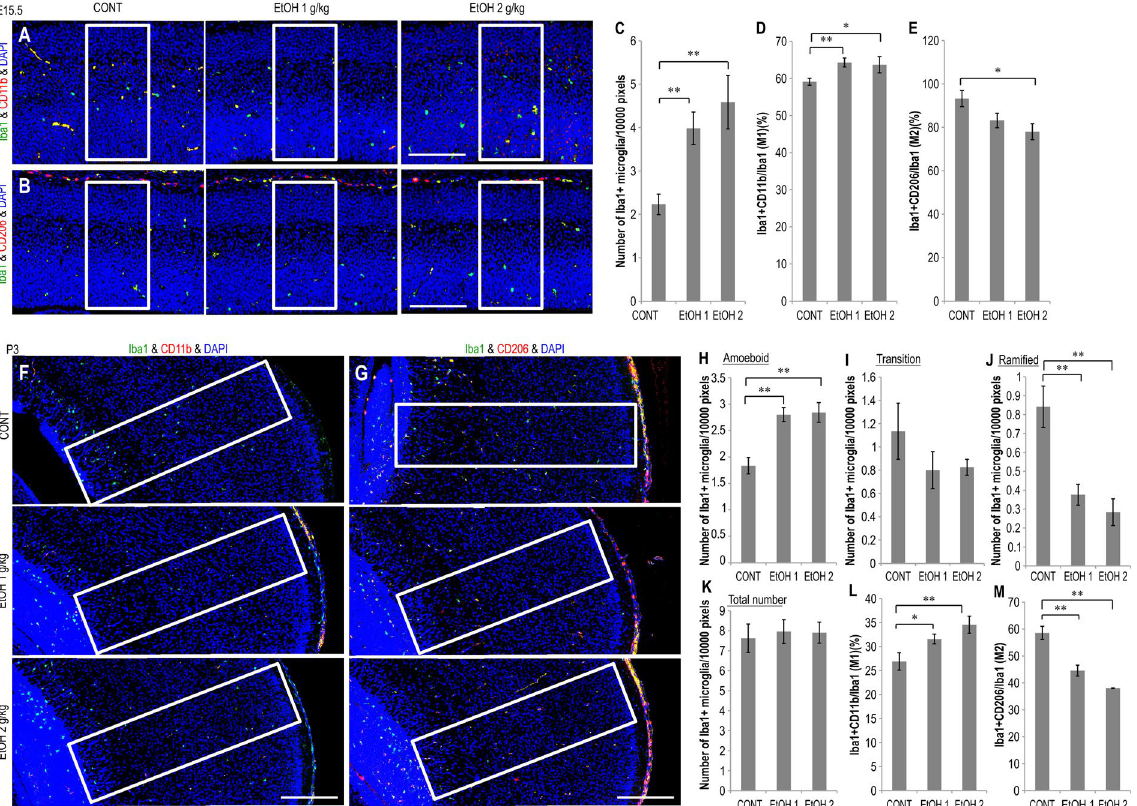
Figure 3. Effects of prenatal EtOH exposure on microglial number, morphology, and M1/M2 ratio in embryos and newborns. Prenatal exposure to EtOH altered microglial number and morphology and increased the ratio of M1/M2 activation in embryos and newborns. ( A , B ) Images of parasagittal sections at E15.5 obtained via double-immunostaining with anti-Iba1 and anti-CD11b (M1 microglial marker) or anti-CD206 (M2 microglial marker) antibodies (n = 6, respectively). ( C ) Graph depicting the index of Iba1 + microglia at E15.5. ( D ) Graph depicting the index of M1 microglia (yellow, Iba1&CD11b + cells/Iba1 + cells × 100) at E15.5. ( E ) Graph depicting the number of M2 microglia (yellow, Iba1&CD206 + cells/Iba1 + cells × 100) at E15.5. ( F , G ) Images depicting the Iba1 + microglial morphological classifications as observed at P3 (anti-CD11b and anti-CD206 antibodies are also shown). The morphological subtypes shown are as follows: amoeboid, active round form; ramified, resting long branching processes with a small cell body; transition, intermediate-type (see Sup. Fig. S3) (n = 6, respectively). ( H – K ) Graph depicting amoeboid ( D ), transition ( I ), and ramified ( J ) microglia as well as total number of Iba1 + microglia ( K ). ( L ) Graph depicting the index of M1 microglia at P3. (M) Graph depicting the index of M2 microglia at P3. Cells were counted in 100 µ m wide sampling boxes (white boxes in A , B , E , and F ); scale bar, 100 µ m, * P < 0.05, ** P < 0.01., compared to 0 mg∙kg − 1 controls using Dunnett’s test or Steel’s